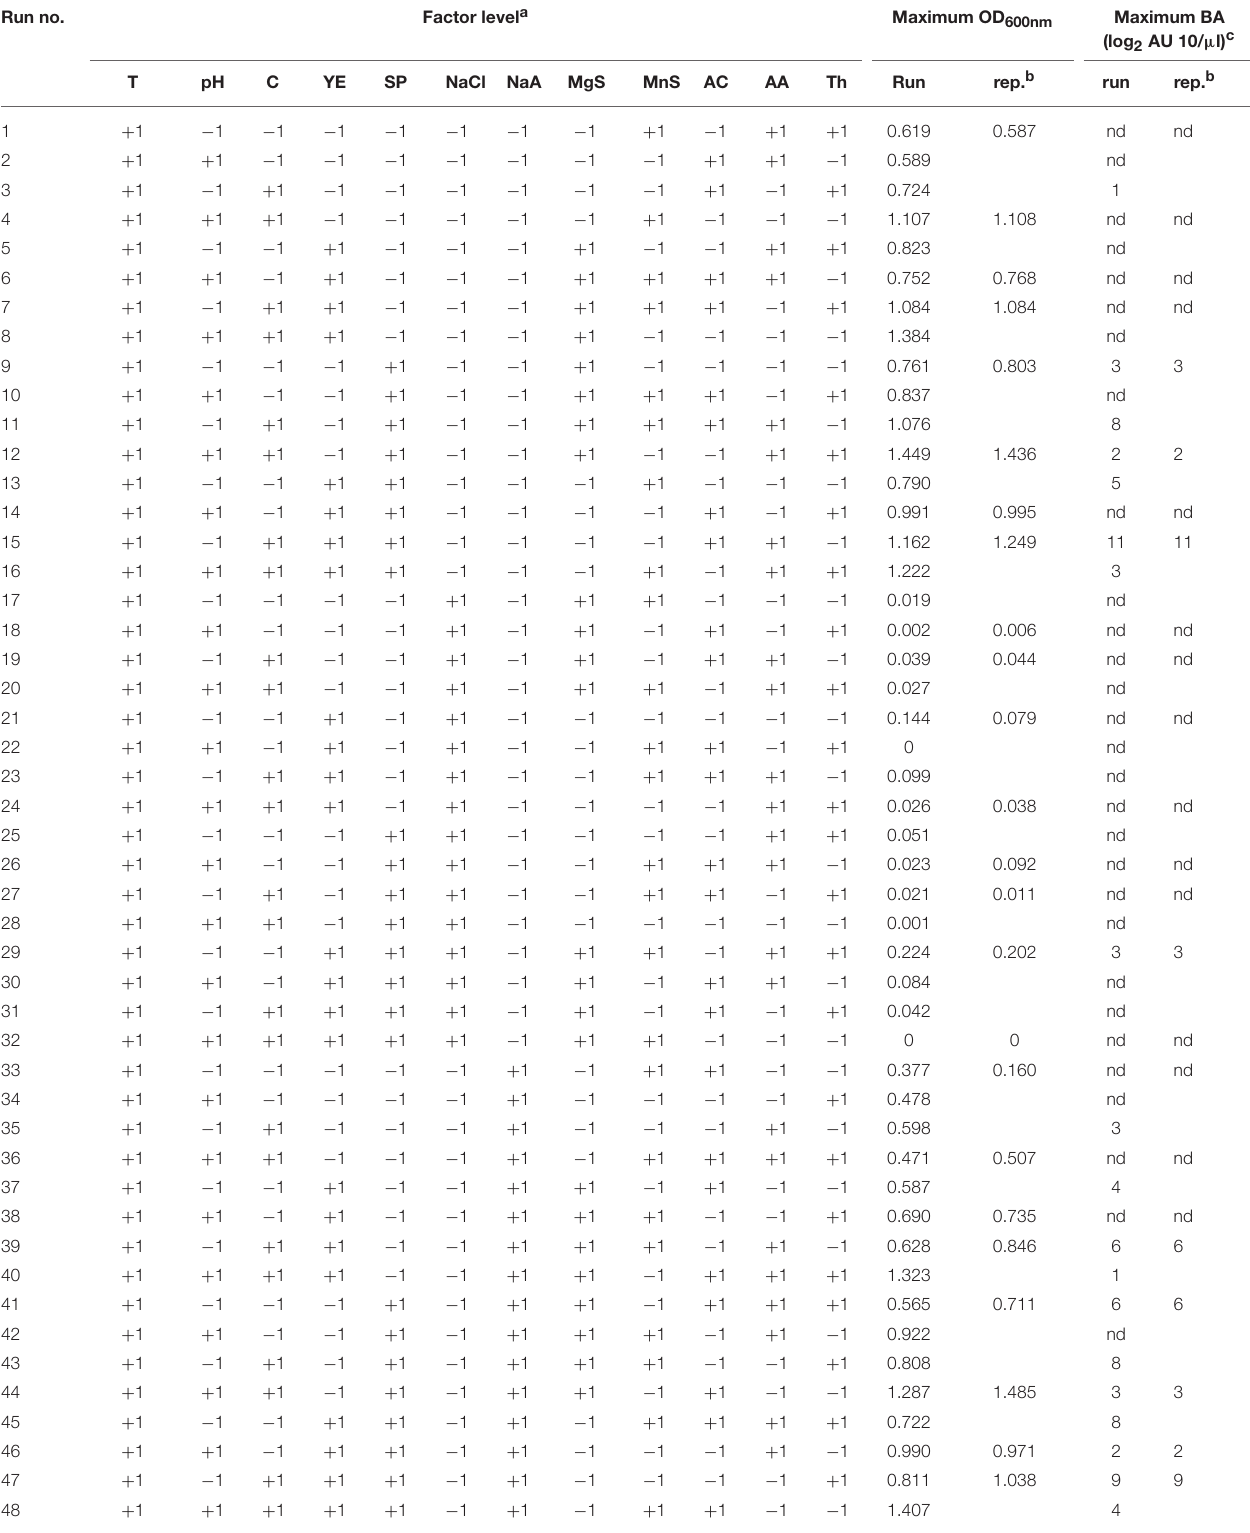
TABLE 1 | Screening experimental design and factor levels (coded values) to estimate the main effect of each factor (and most of the order one interactions without aliasing) on the growth of C. divergens V41 (OD max ) and its maximal bacteriocin activity (BA max ). Run